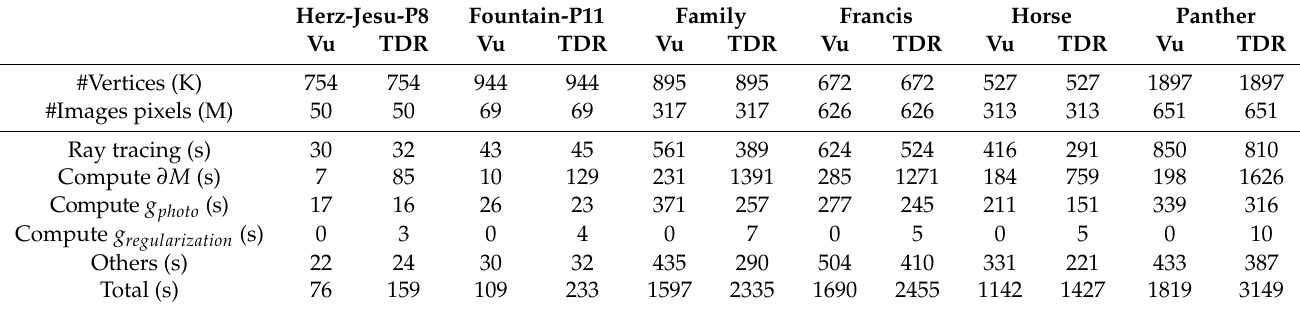
Table 6. The time consumption of critical steps in the TDR and the baseline